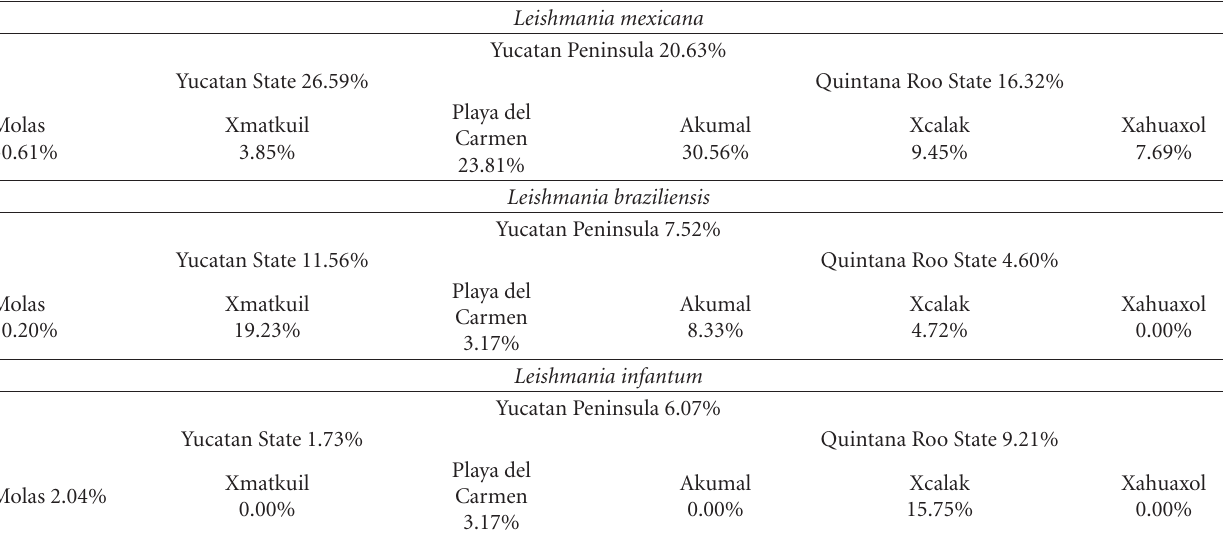
Table 1: Prevalence of antibodies to Leishmania braziliensis , L. infantum and L. mexicana infection in dogs from Peninsula of Yucatan